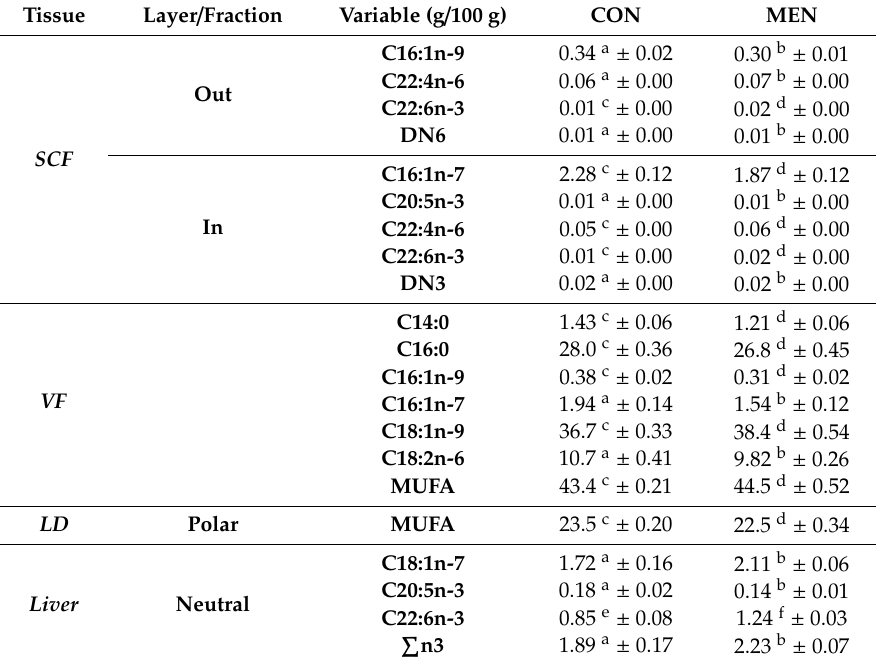
SCF = subcutaneous fat; VF = visceral fat; LD = longissimus dorsi ; DN6 = total activity of the desaturases of n6; DN3 = total activity of the desaturases of n3; MUFA = sum of monounsaturated FA. Di ff erent superscripts indicate significant di ff erences: a (cid:44) b p < 0.1; c (cid:44) d p < 0.05; e (cid:44) f p <